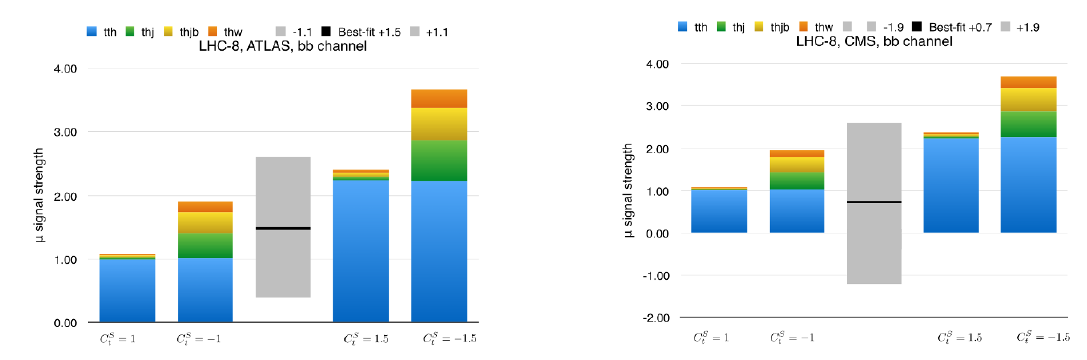
Figure 7 . Category b (cid:22) b : accumulated signal strengths (cid:22) ATLAS at LHC-8 obtained by stacking the various thX contributions on the t (cid:22) th one for C S +1 ; (cid:0) 1 ; +1 : 5 ; (cid:0) 1 : 5 from left to right. The grey columns in the center represent the current 8 TeV LHC data from table 1.